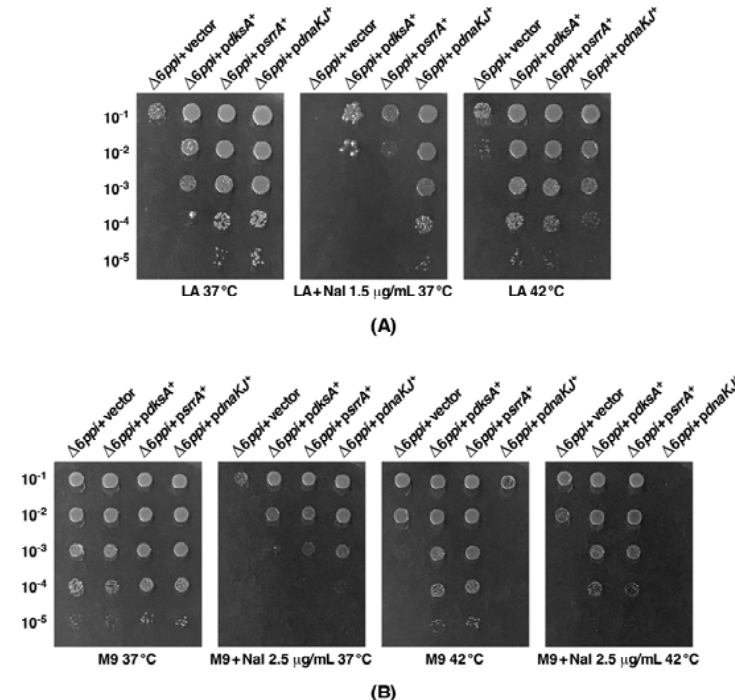
Figure 4. Overexpression of either the dksA gene or the srrA gene or the dnaK / J operon can rescue the sensitivity of ∆ 6 ppi bacteria to nalidixic acid (Nal) to varying levels depending upon growth conditions. Exponentially grown cultures of the wild type and its isogenic ∆ 6 ppi derivatives transformed with the vector pCA24N alone, the plasmid expressing either the dksA gene or the srrA gene or the dnaK / J operon were grown as described in the legend to Figure 3 and the bacterial growth measured on either LA medium ( A ) or on M9 medium ( B ) at indicated temperature. The concentration of Nal, when added to growth medium, is depicted. For the induction of gene expression, 75 µ M IPTG was added.